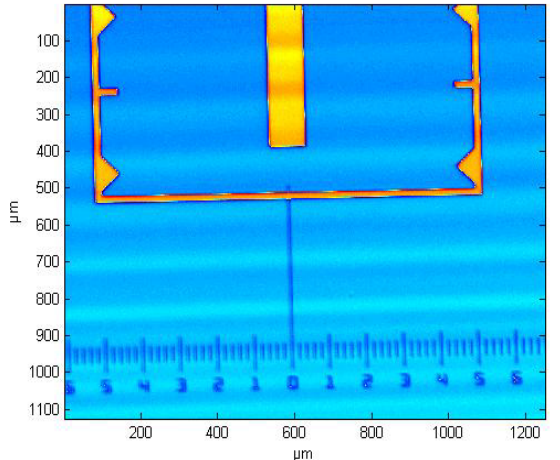
Figure 10. The measurement results by the white light scanning interferometry.